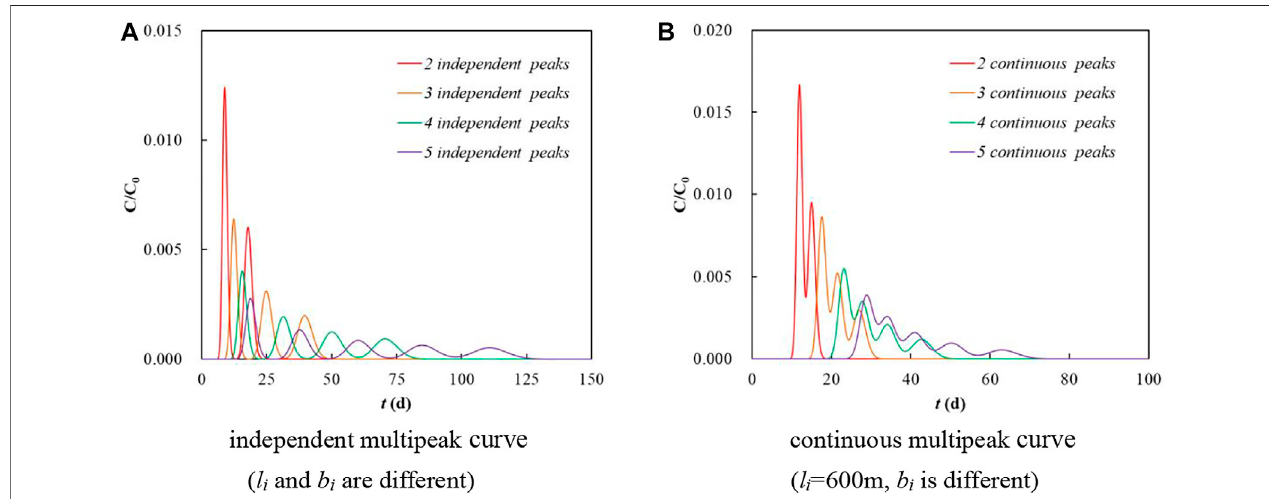
FIGURE 12 | Tracer output curve of interwell multifracture in parallel under different parameters. (A) independent multipeak curve ( l i and b i are different) (B) continuous multipeak curve ( l i =600 m, b i is different).